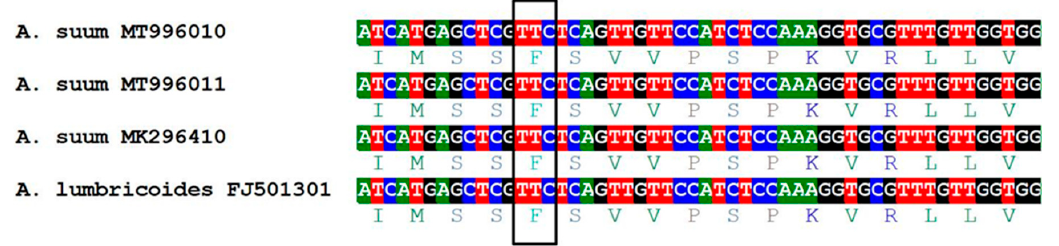
Figure 4. The partial nucleotide and amino acid sequences from the fragment of β -tubulin gene around codon 167 of the selected isolates of Ascaris suum eggs obtained in this study (GenBank, MT996010, MT996011) and deposited earlier (GenBank, MK296410, FJ501301). The frame marks codon 167.